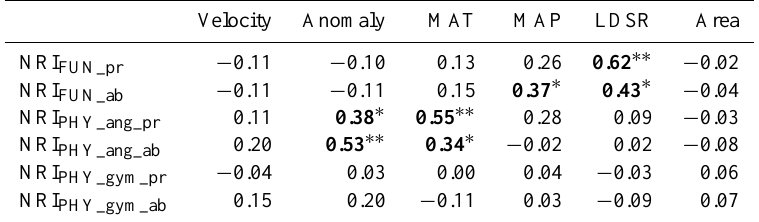
Table 2. Adjusted R 2 for single predictor OLSs of each diversity index against each explanatory variable. Significant values are given in bold; ∗ p < 0 . 05; ∗∗ p < 0 . 01.